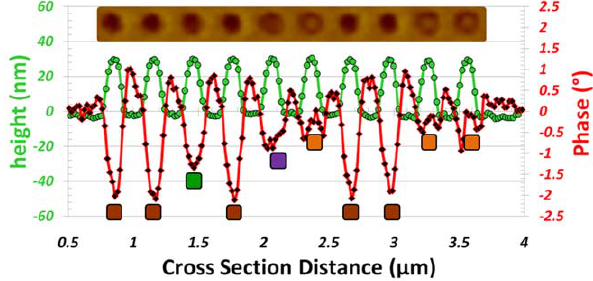
Figure 11. Quantification of ML MFM signals. AFM/MFM section line analysis of the row of nanopillars located between the red arrows in Figure 8. The color boxes represent the different magnetic states as shown in Figure 1. The inset is a cropped section of the MFM image, taken between the two red arrows.